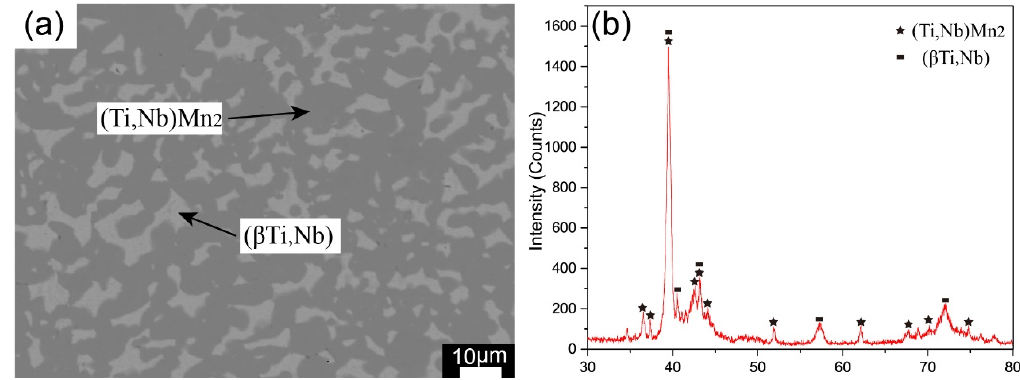
Figure 16. Alloy B1 annealed at 1273K for 60 days: ( a ) BSE images, ( b ) XRD patterns.